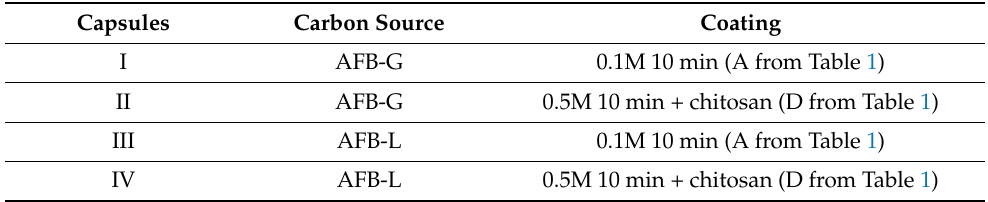
Table 2. Capsule formulations used to test probiotic viability over time, to study the impact from the carbon source used and from the crosslinking of the